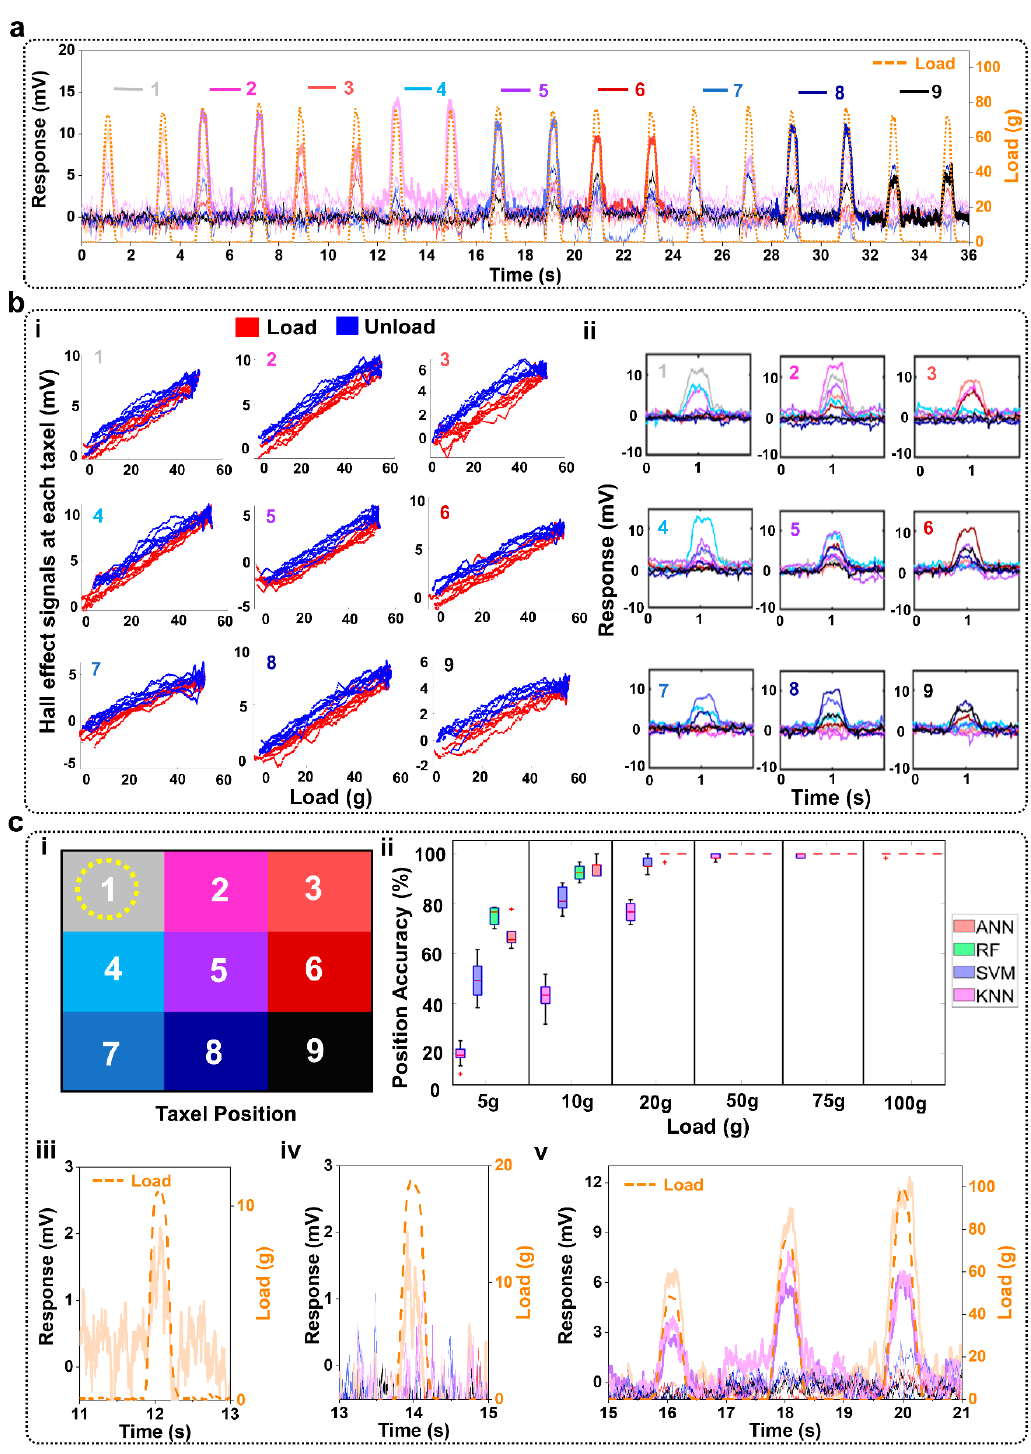
Figure 4. Classification accuracy of 15% ferrofluid Hall effect sensor array. ( a ) Illustrative responses and load data at the nine taxel locations. ( bi ) Load changes with Hall effect signals at each taxel, ( bii ) Individual taxel responses under 100 g load. ( ci ) Taxel location color code indicating illustrative data is from taxel 1. ( cii ) Classification accuracies to detect the different locations a load was applied with each of the six different loads (n = 30 repetitions/load). ( ciii ) Taxel 1 response to the 10 g load applied at taxel 1. ( civ ) All taxel responses from a 20 g load applied at taxel 1. ( cv ) All taxel responses under different loads (50 g, 75 g, 100 g) applied at taxel 1.